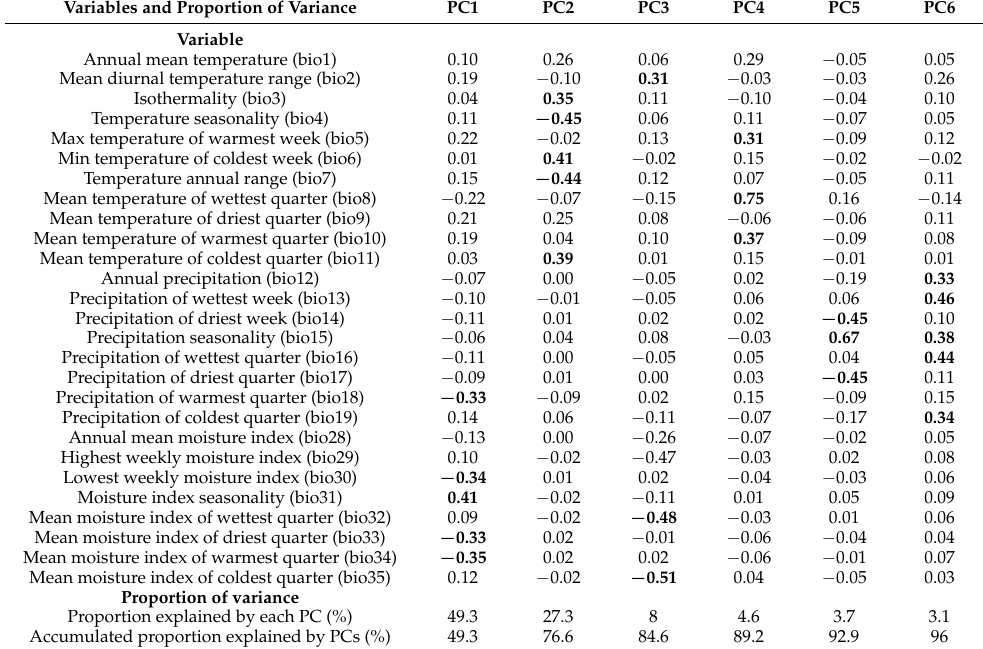
Table 2. Summary of the principal component analysis of 27 bioclimatic variables used in correlative modeling. Principal component (PC) axes were selected until the cumulative explanation proportion reached 95% or more of the total variation of the original matrix. Loadings of PCs for each variable are presented, as well as PC’s eigenvalues, the proportion of explained variance of each PC, and accumulated proportion of explained variance. The largest loadings (positive or negative) for each component (>0.30) are indicated with bold